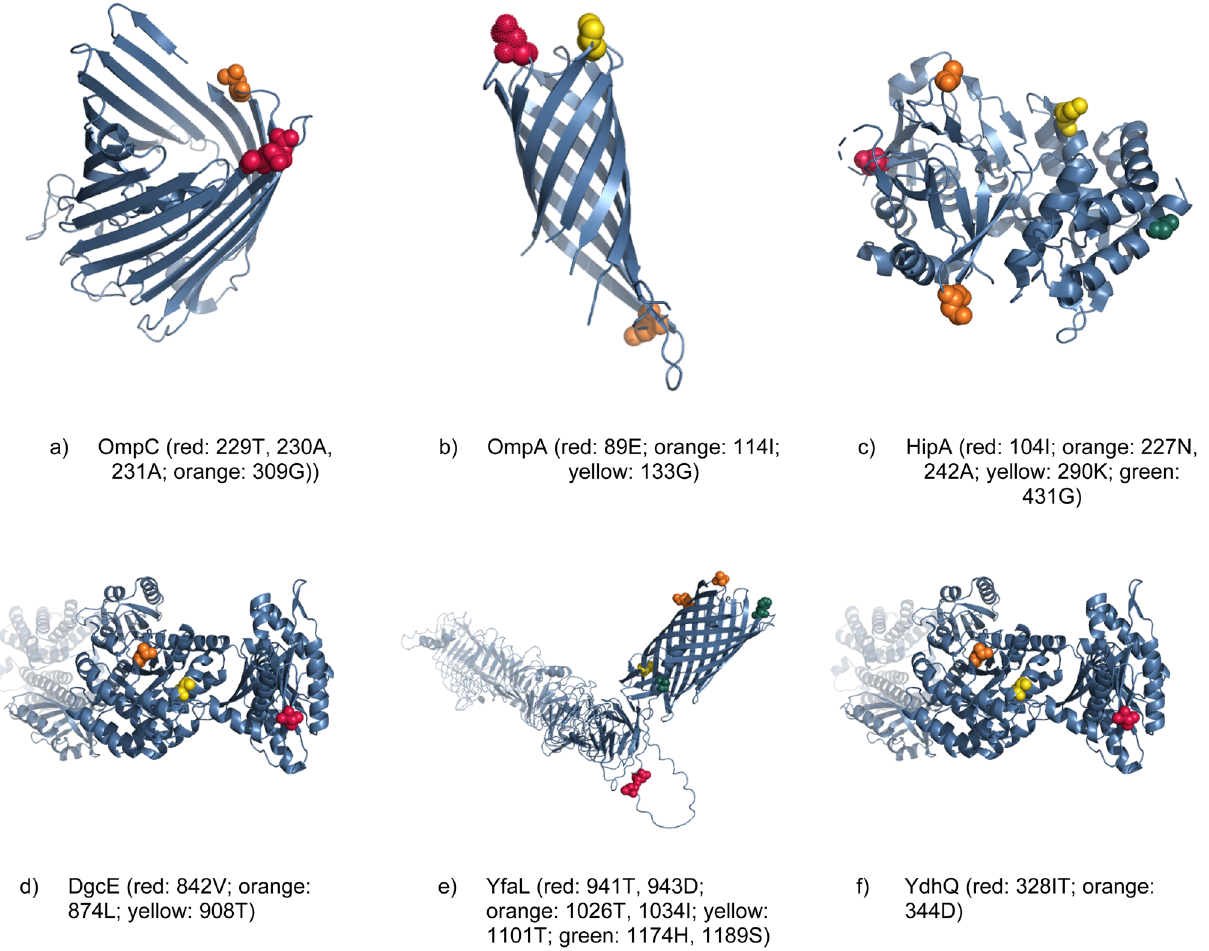
Figure 6. The 3d protein structure of six positively selected core genes with a possible link to antibiotic resistance. The positively selected sites with a probability greater than 0.95 are shown as red/orange/yellow/green